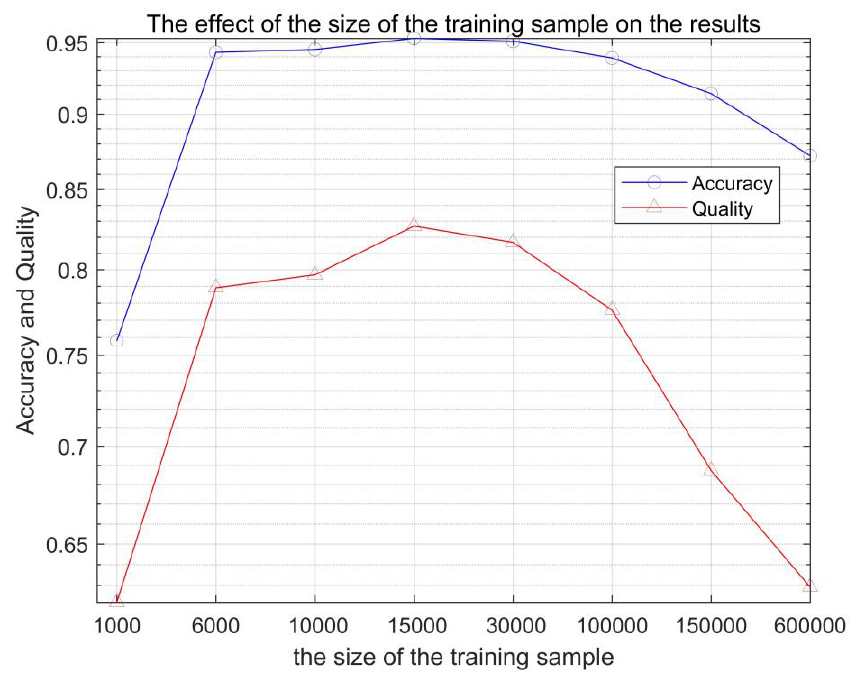
Figure 8. The effect of the size of the training sample on the results.